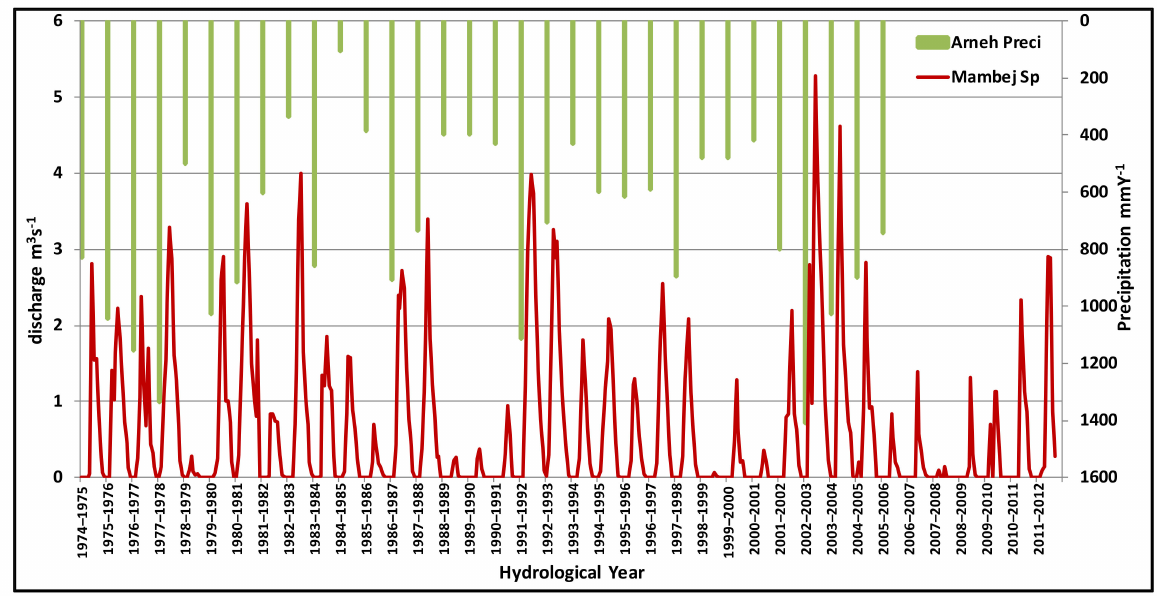
Figure 10. The variations of the monthly discharge of Mambej spring and the annual amount of precipitation measured at Arneh